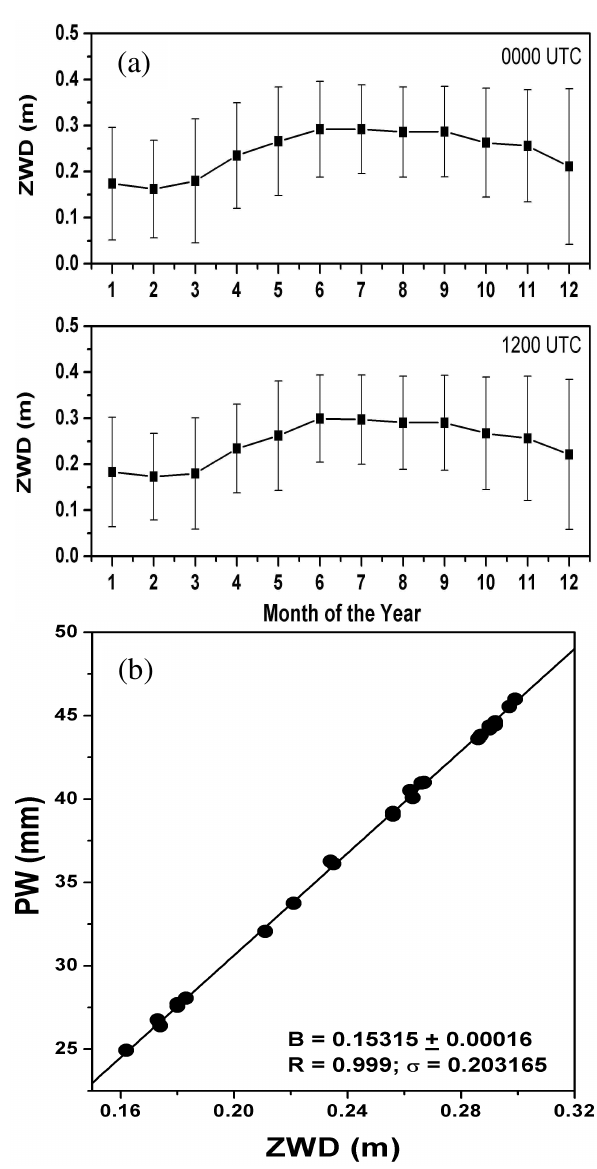
Fig. 3. Monthly mean values of wet range error in the zenith direc- tion (ZWD) for Bangalore at 00:00 UTC and 12:00 UTC, respec- tively in the upper panel and lower panel estimated by using the mean profiles of partial water vapor pressure ( e) and temperature ( T ) for the period 1995–1997, obtained from radiosonde data (ver- tical bars in both the panels are standard deviations in each month due to the day-to-day variations of e and T , estimated by apply- ing the error propagation formula (Ku, 1966)) (a) , and dependence of Integrated columnar (precipitable) water vapor (PW) on ZWD is derived using monthly mean values of ZWD and PW (b)